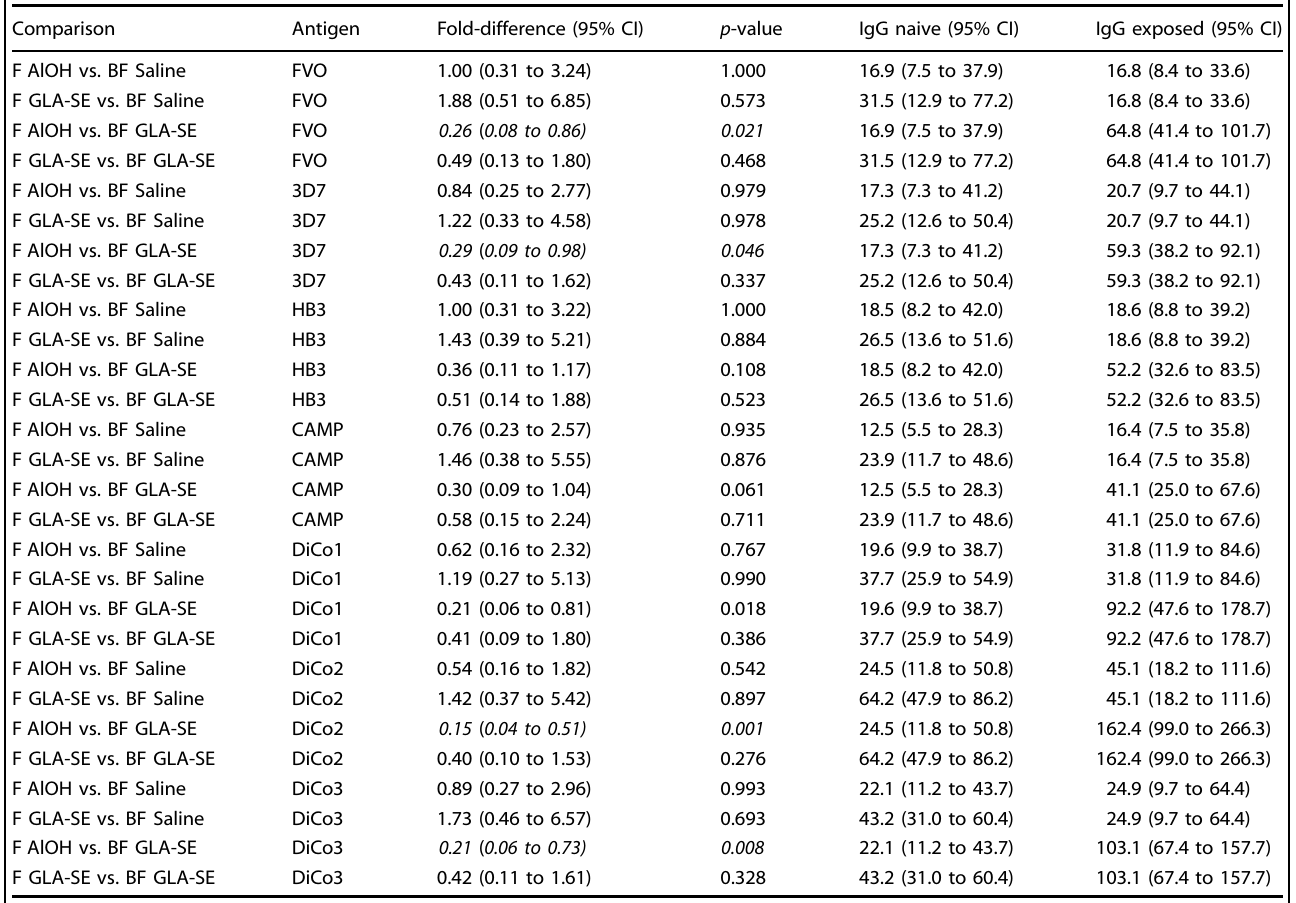
Table 1. Comparison of Week 30 IgG levels in malaria-naive and malaria-exposed adults.